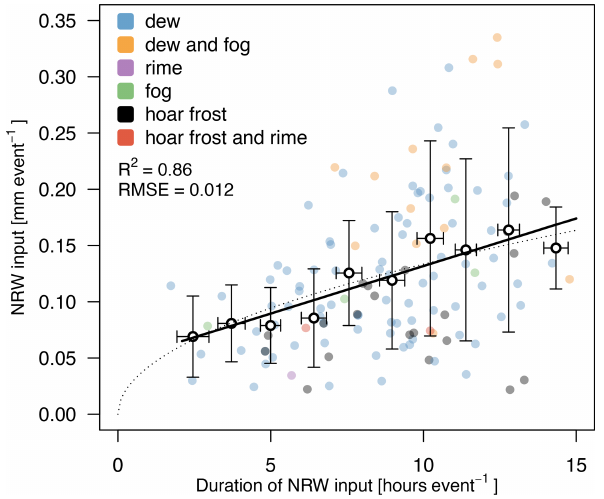
Figure 9. The relationship of actual NRW input as a function of actual NRW input duration from 12 months of NRW inputs. NRW inputs were binned into 10 bins of equal width covering the en- tire data range of the NRW input duration. Horizontal and vertical whiskers indicate the standard deviation (SD) of the available data within each bin relative to the respective bin average (open circles). Different colours indicate different types of NRW inputs. There is a strong linear relationship ( R 2 = 0 . 86, p < 0 . 001) between actual NRW input and actual NRW input